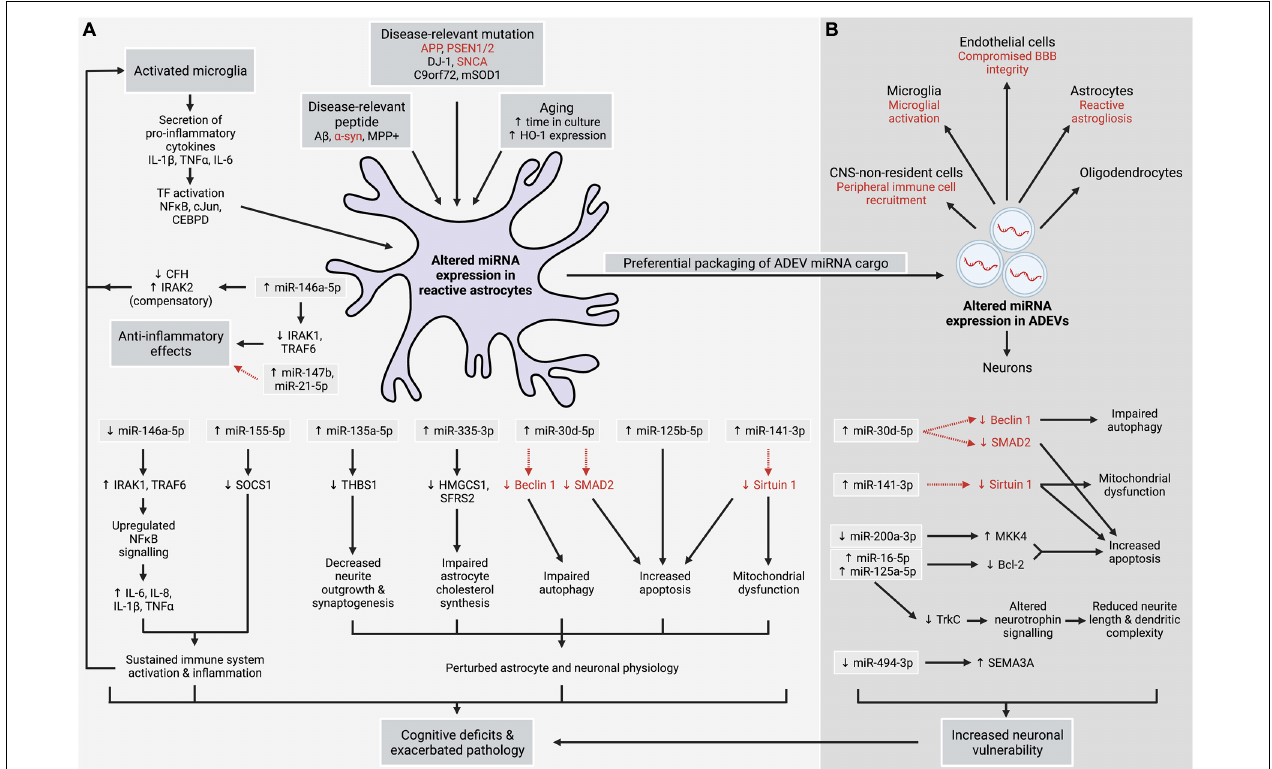
FIGURE 1 | Altered expression of miRNA in astrocytes (A) and astrocyte-derived extracellular vesicles (ADEVs) (B) , arising from neurodegenerative, inflammatory, and ageing processes, contributes to sustained central nervous system (CNS) inflammation, neuronal injury, dysregulated autophagy, and mitochondrial dysfunction in astrocytes and neurons, and increased apoptosis. Uptake of ADEVs by neurons and other cell types is suggested to have numerous downstream effects. Together, these insults can exacerbate CNS pathology and contribute to the cognitive and motor symptoms observed in neurodegenerative conditions, indicating that dysregulated expression of astrocytic miRNA plays a central role in neurodegenerative disease. Alternatively, anti-inflammatory effects are observed in response to certain stimuli. Red font and dashed red arrows denote postulated